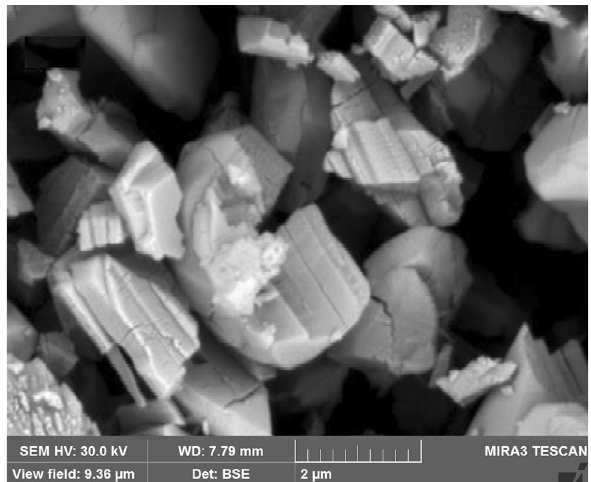
Figure 5. SEM image of the synthesized AlTp.